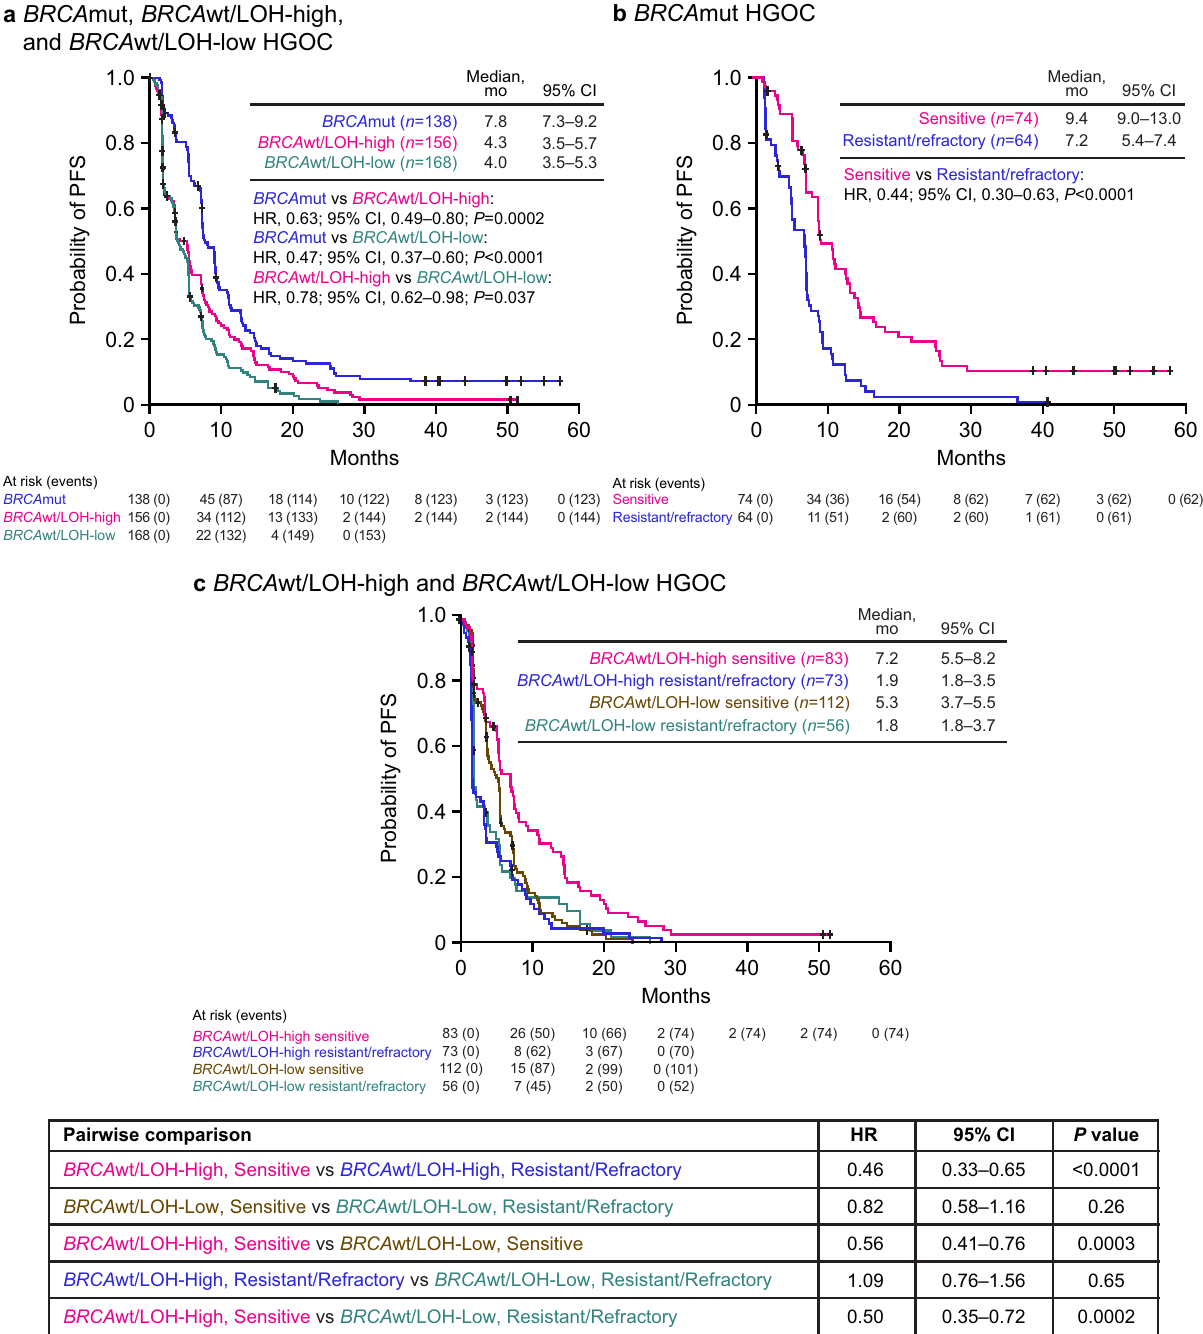
Fig. 1 PFS by molecular subgroup and platinum-sensitivity status. a PFS in patients with BRCA mut (blue), BRCA wt/LOH-high (magenta), and BRCA wt/ LOH-low (teal) HGOC. b PFS in patients with BRCA mut HGOC that are platinum resistant/refractory (blue) or platinum sensitive (magenta). c PFS in patients with BRCA wt/LOH-high HGOC that are platinum resistant/refractory (blue) or platinum sensitive (magenta) and PFS in patients with BRCA wt/ LOH-low HGOC that are platinum resistant/refractory (teal) or platinum sensitive (brown). P values were computed using a Cox proportional hazard model. The interaction between molecular subgroup and platinum status was also tested in the Cox proportional hazard model and found to be signi fi cant ( P < 0.05). BRCA BRCA1 or BRCA2 , CI con fi dence interval, HGOC high-grade ovarian carcinoma, HR hazard ratio, LOH loss of heterozygosity, mut mutated, PFS progression-free survival, wt wild